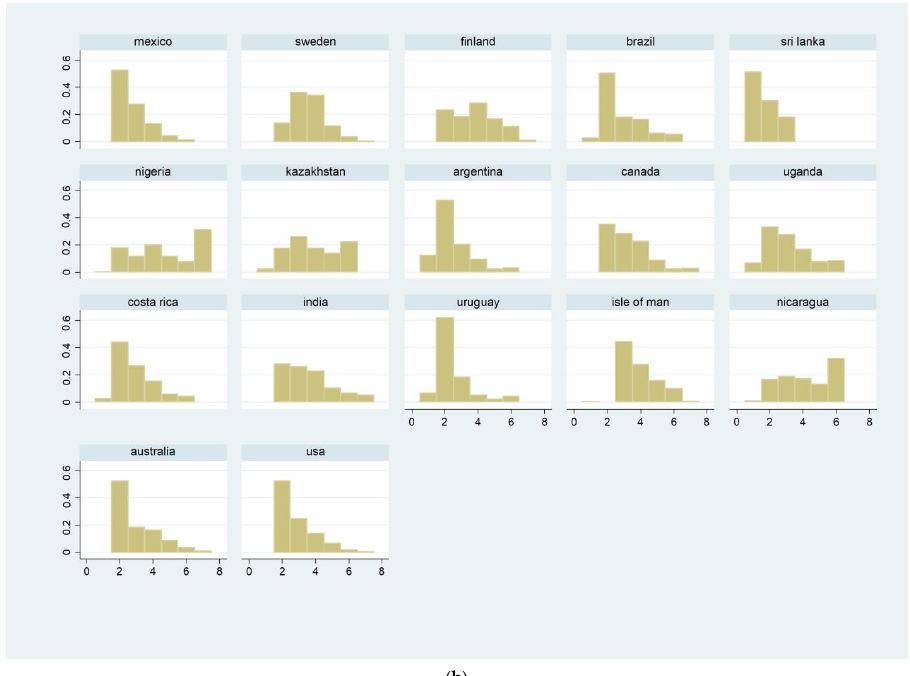
Figure 1. ( a ) Maximum Quantity Distribution among male drinkers. (Note: see x-axis key under female drinkers charts; y-axis is proportion). ( b ) Maximum Quantity Distribution among female drinkers. X-Axis: Sub-HID levels: 1 = <1 drink, 2 = 1 – 2 drinks, 3 = 3 – 4 drinks, 4 = 5 – 7 drinks; HID levels: 5 = 8 – 11 drinks, 6 = 12 – 20* drinks, 7 = 20+* drinks (*12 – 24 and 24+ drinks for Sweden and the USA).